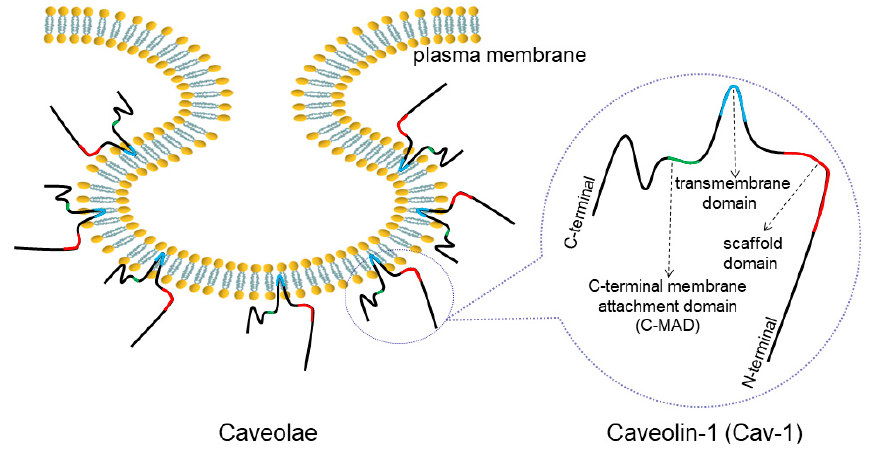
Figure 1. Structure of caveolae and Cav-1. Caveolae is an Ω -shaped structure located on cell membranes. Cav-1 is a main component of caveolae, consisting of a C-MAD, transmembrane, and scaffolding domains.